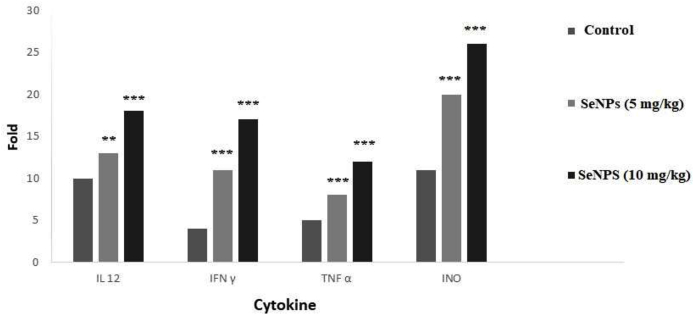
The mRNA levels of IFN-γ, TNF-α, IL-10, IL-12, as well as iNO in mice. **p < 0.01; ***p < 0.001 statistically significant.